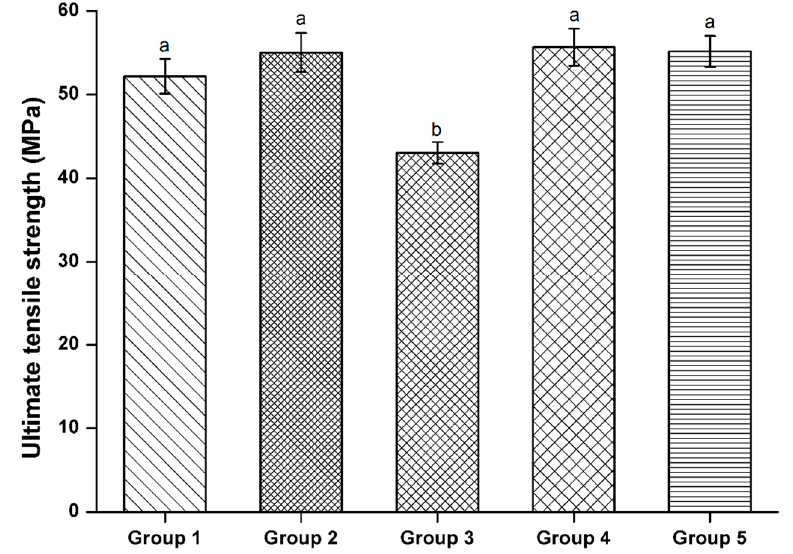
Figure 4. Ultimate tensile strength of the five experimental groups. Groups 1, 2, 4, and 5 were not significantly different from one another ( p > 0.05, Tukey HSD test). Group 3 had significantly lower ultimate tensile strength compared to any of the other groups ( p < 0.05).